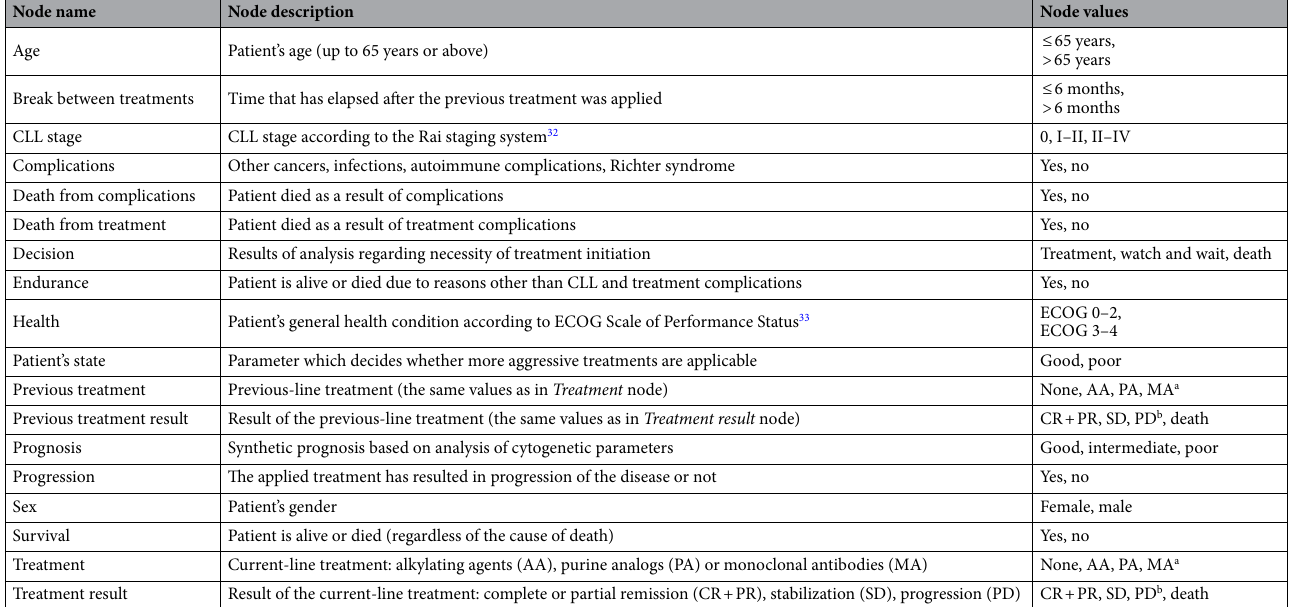
Table 3. Nodes of the treatment effect network. a AA alkylating agents, PA purine analogs, MA monoclonal antibodies. b CR + PR complete + partial remission, SD stable disease, PD progressive disease.